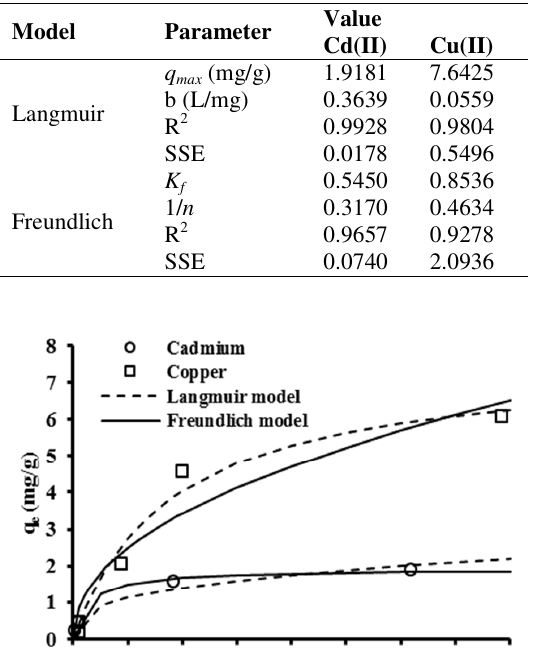
Values of parameters for models of Langmuir and Freundlich for removal of cadmium and copper onto CSIO.